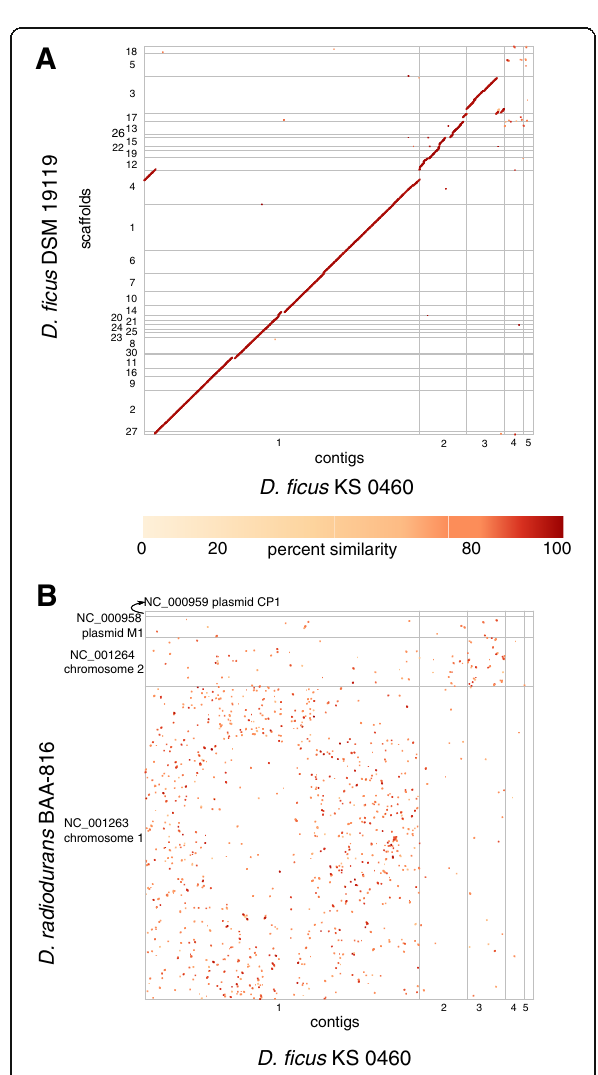
Fig. 3 Genomic alignment of D. ficus KS 0460 with D. ficus DSM 19119 or D. radiodurans BAA-816. a Strain KS 0460 versus strain DSM 19119. b Strain KS 0460 versus strain BAA-816. Six-frame translations of scaffolds were aligned with Mummer 3.23. Homologous regions are plotted as dots , colored according to the similarity of the aligned loci. Diagonal lines of dots represent syntenic regions. Only contigs longer than 20 kbp are shown. Axes are not drawn to